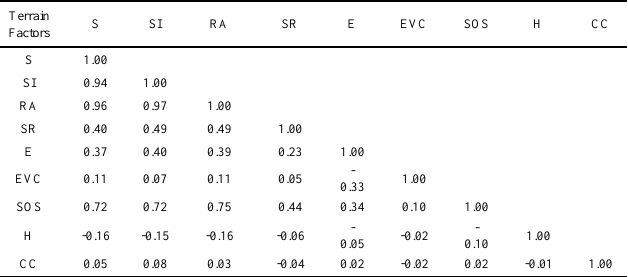
Table 1. Correlation coefficients